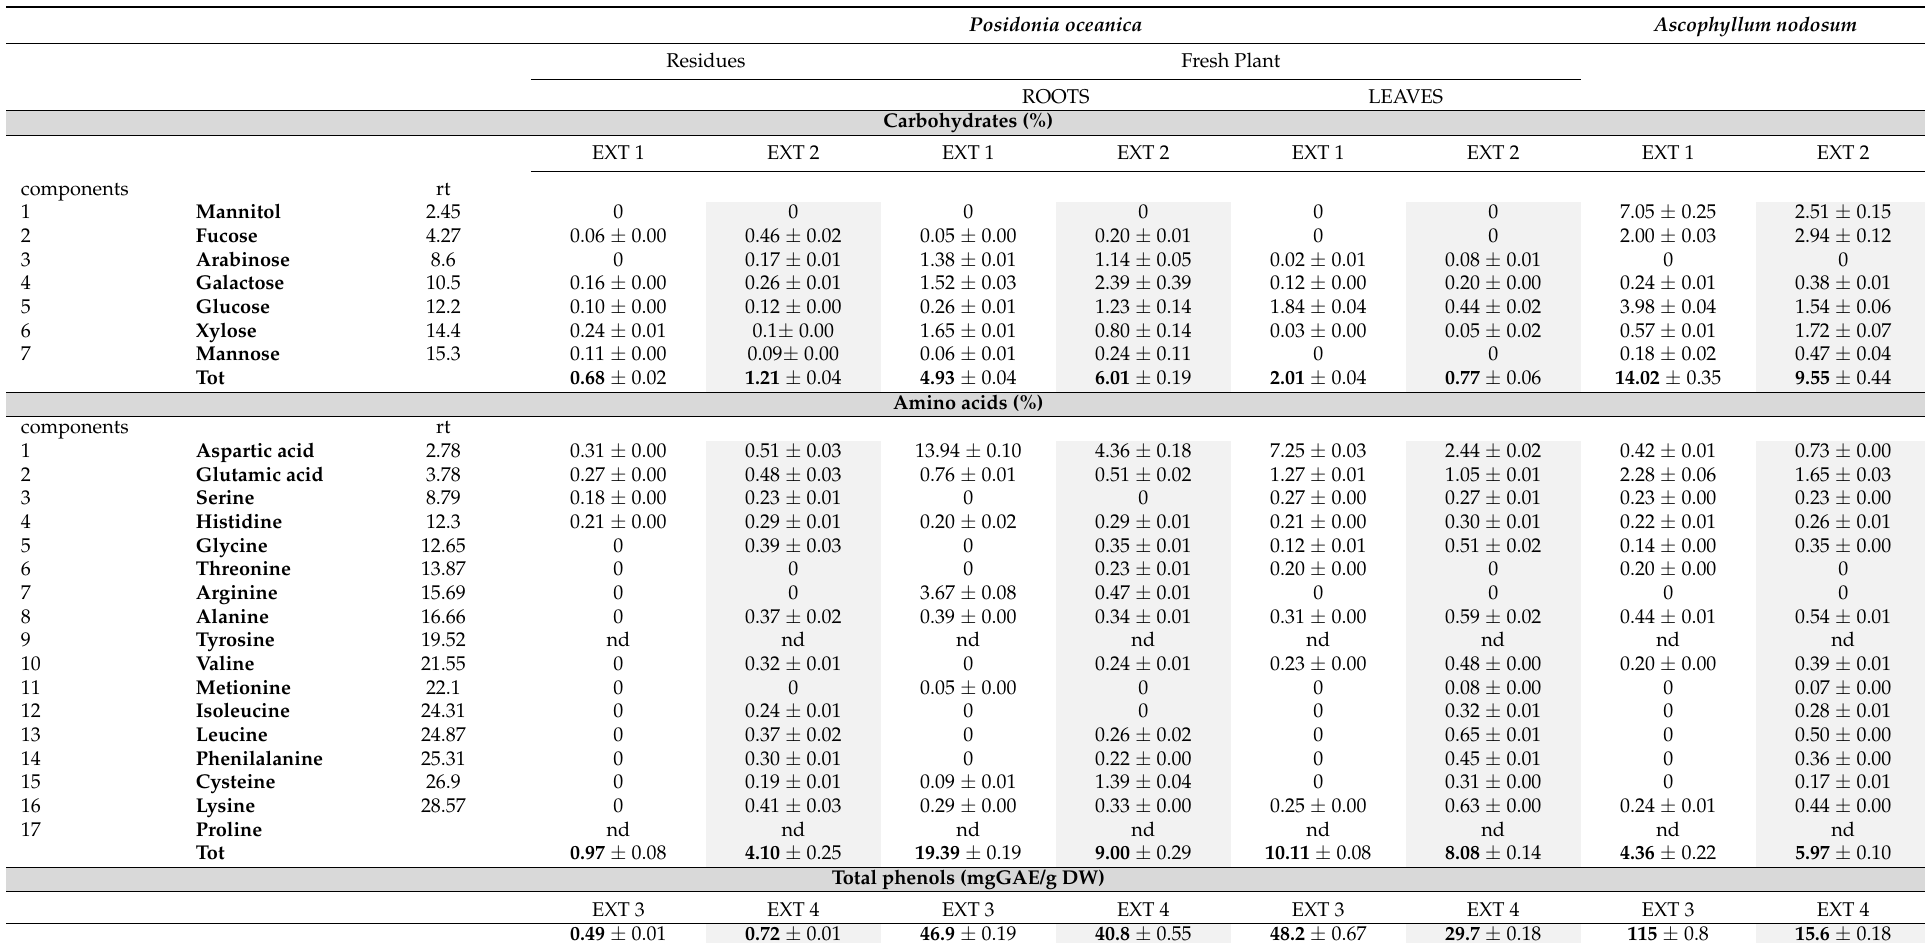
Table 3. Carbohydrate, amino acid, and total phenolic content of Posidonia oceanica (residues and fresh plant, divided into leaves and roots) and Ascophyllum nodosum (results of carbohydrates and amino acids are expressed as percentages of dry weight; nd: not detected; rt: retention